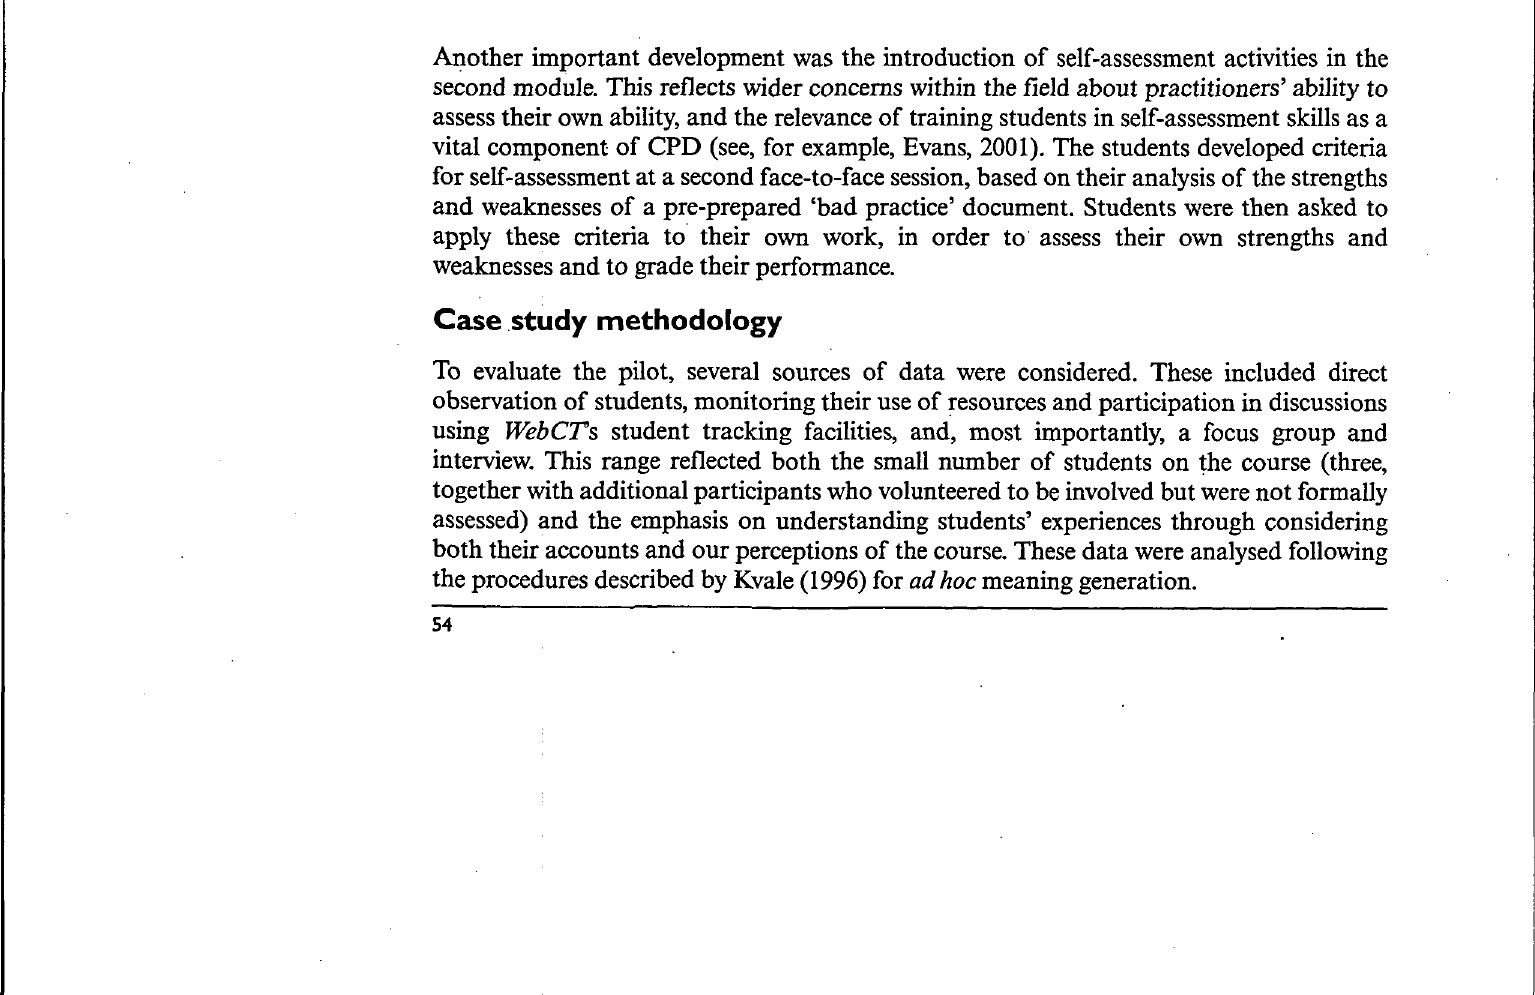
Figure 2: An image and excerpt from the assessment on judging bitewing